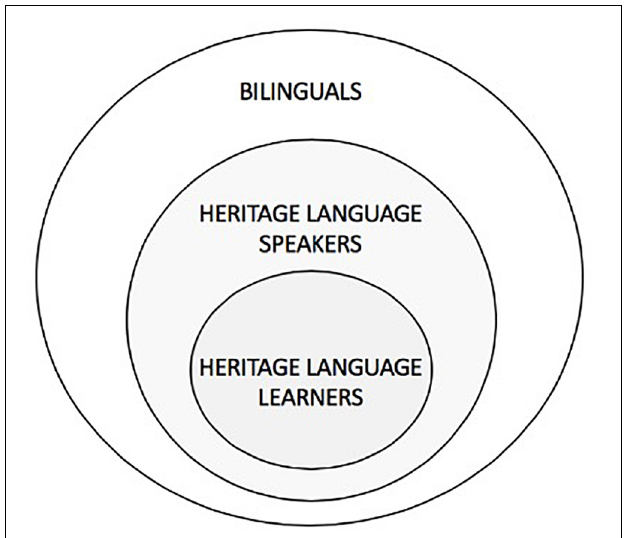
FIGURE 1 | Relationship between bilinguals in general, heritage language speakers, and heritage language